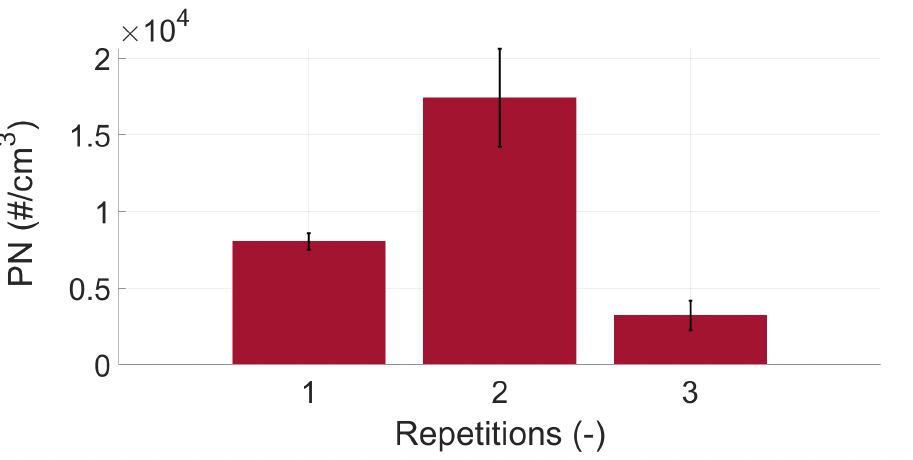
Figure A3. The mean values of PN measurements of ethanol (cut-off: 7 nm). The mean values of the PM measurements for gasoline and ethanol are presented in Figures A4 and A5, respectively. For gasoline, the mean PM values were relatively close, with one discrepancy for repetition 4. For ethanol, all the mean values were comparable. The variation in PM was less than in PN for both